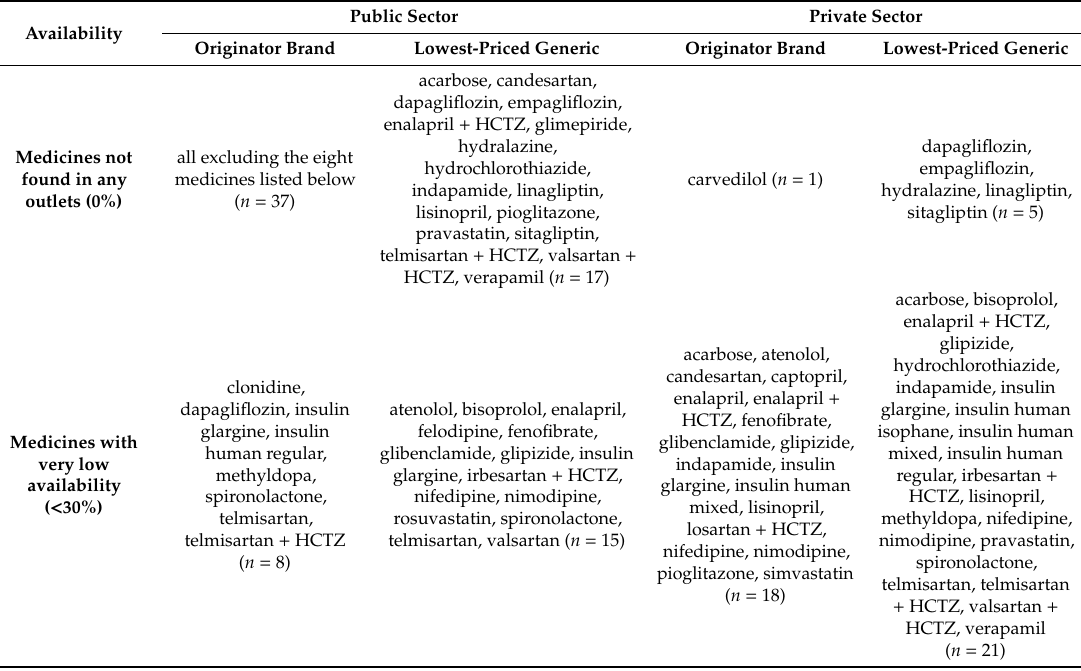
Table A2. Availability of medicines in the public and the private